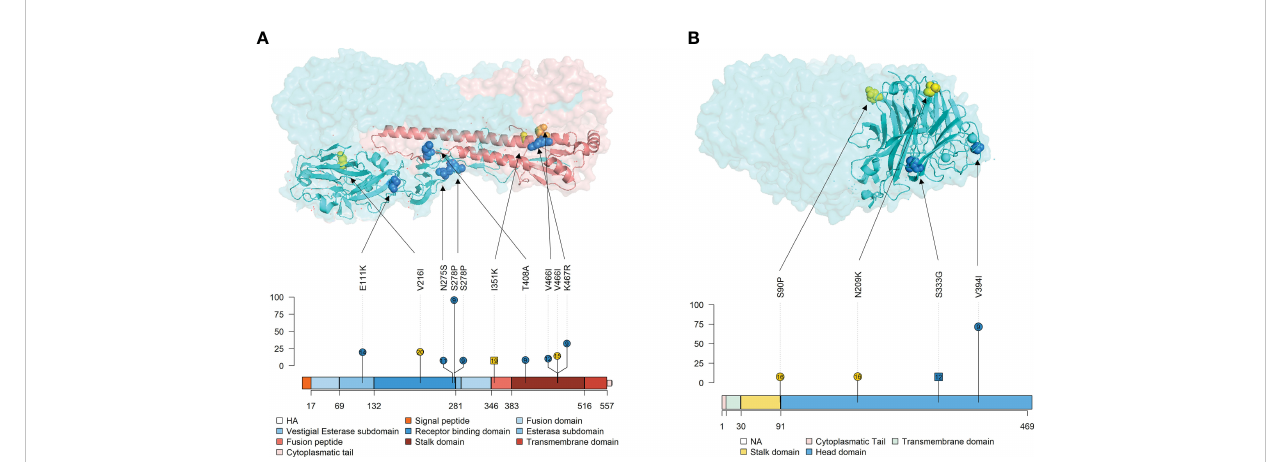
FIGURE 10 Localization of nonsynonymous substitutions, with an allele frequency greater than 5%, found in HA and NA surface glycoproteins on 3D and lolliplot protein representation. (A) HA trimer structure (PDB accession no. 3LZG (Xu et al., 2010)) and domains representation by lolliplot. HA1 and HA2 domains are represented in different tones of blues and reds respectively. (B) NA tetramer structure (PDB accession no. 4B7Q (van der Vries et al., 2012)) and domains representation by lolliplot. In both 3D representations, substitutions are highlighted in blue, yellow and orange if it were found in samples from vaccinated, nonvaccinated and both, respectively. In the lolliplot representation, substitutions are plotted in blue and yellow (vaccinated or nonvaccinated groups, respectively), circle and squared shapes (H1N1 and H3N2 subtypes, respectively) and number on shapes indicate the animal in which each substitution was found. In the ordinate axis, the substitution allele frequency is indicated. The different surface glycoprotein domains are indicated in lolliplot legends.